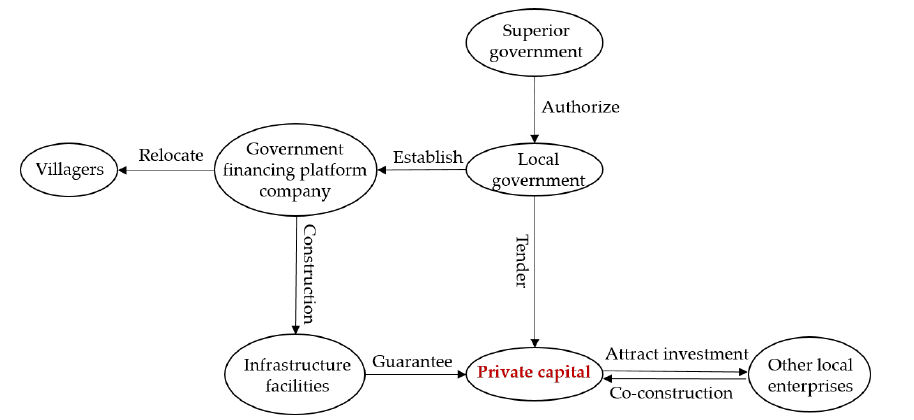
Figure 12. Construction and operation relationship of the multiple entities of Sujia.